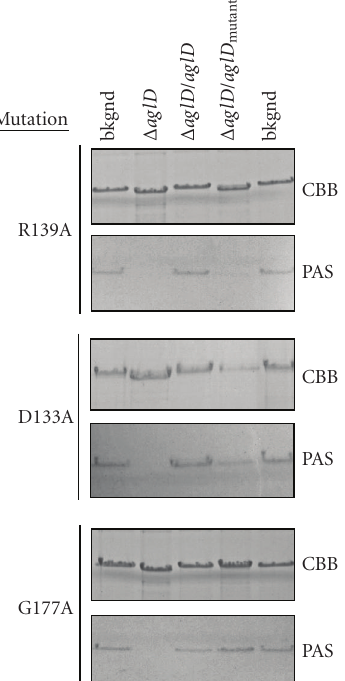
Figure 6: The conserved Arg139 residue is needed for AglD activity, unlike the conserved Asp133 or Gly177 residues. Site-directed mutagenesis was performed to generate CBD-AglD containing mutations of Asp133, Arg139, and Gly177, as listed on the left of each panel. For each mutant, the upper and lower panels respec- tively show the Coomassie- and PAS-stained S-layer glycoprotein from the background strain (lanes 1 and 5), from the aglD deletion strain (lane 2), from the aglD deletion strain complemented with a plasmid encoding CBD-AglD (lane 3), or from the aglD deletion strain complemented with a plasmid encoding CBD fused to mutated AglD (lane 4).